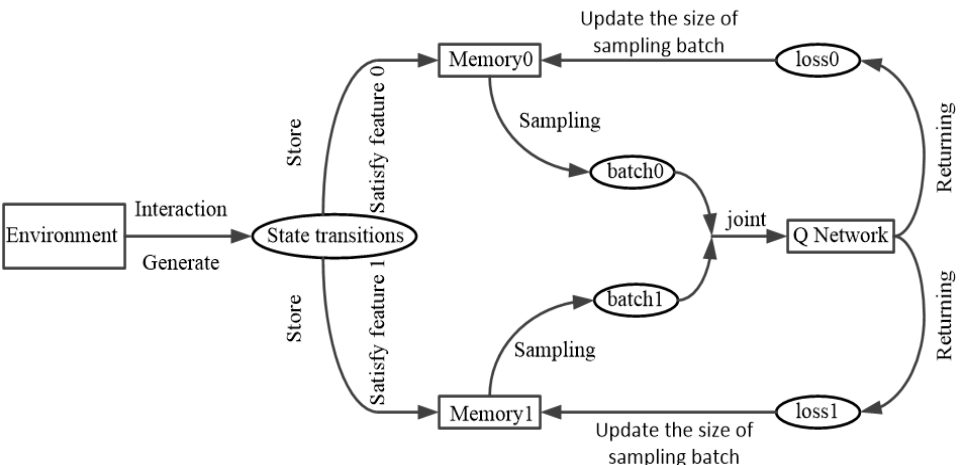
Figure 1. Schematic diagram of the experience classification training method.